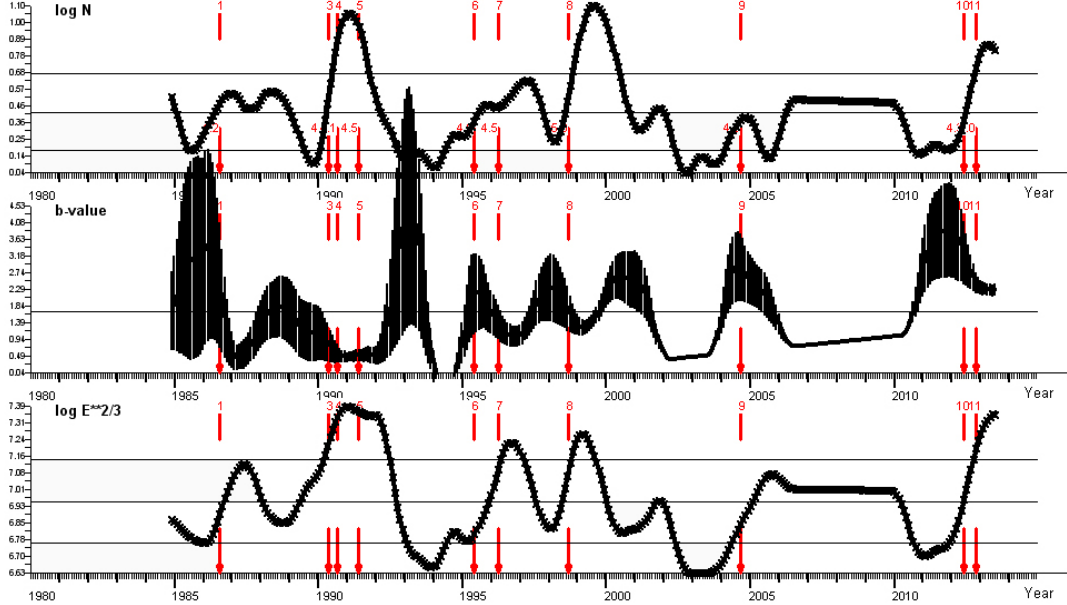
Figure 4. Temporal variation of the seismic parameters log N(t) , b value and log E 2 / 3 , with their respective standard errors. Origin time and magnitude of all strong earthquakes with magnitude M L ≥ 4 . 0 are shown as numbered arrows perpendicular to the time axis in the period 1983–2013.